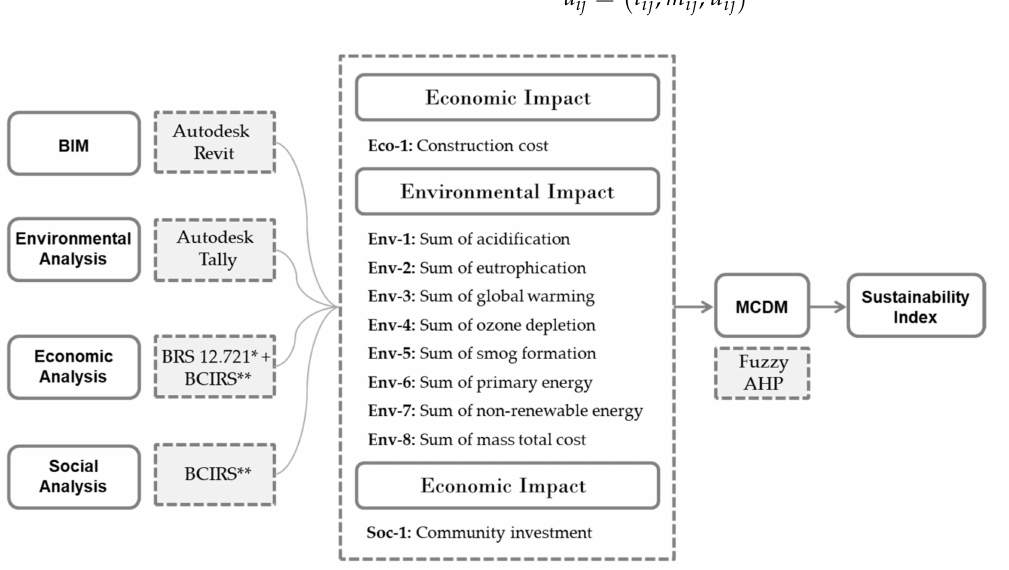
Figure 3. Sustainability analysis methodology; where: * BRS 12.721: Brazilian Regulatory Standard 12.721; ** BCIRS: Brazilian Cost and Index Research System.